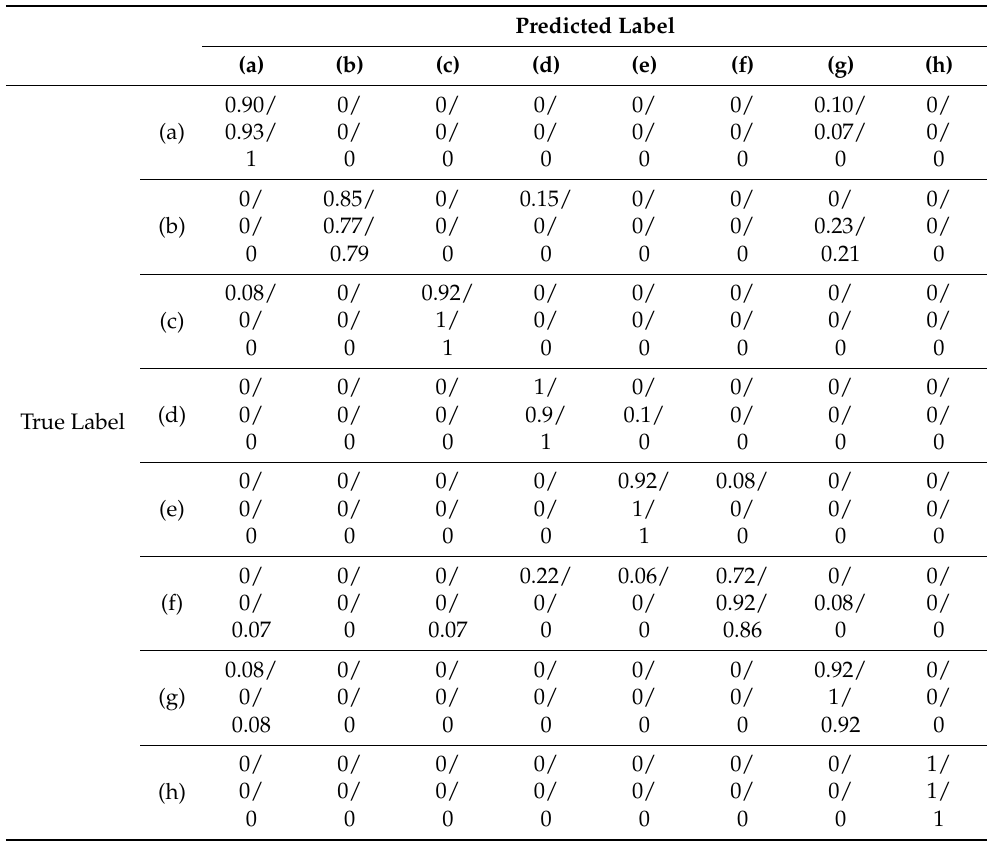
Table 2. Confusion matrix of the CNN